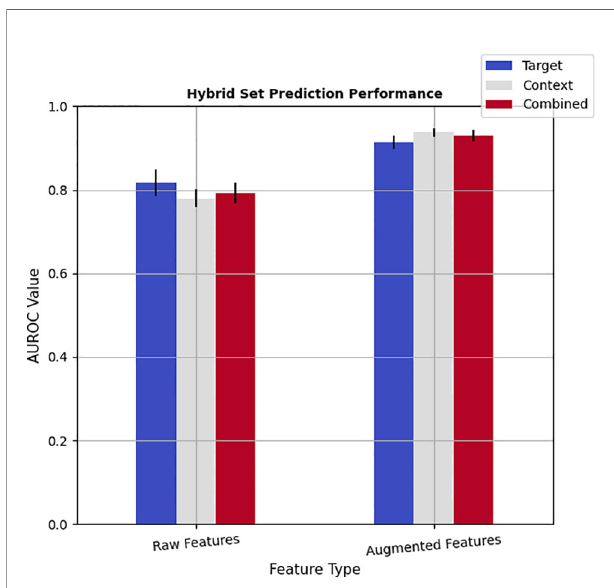
FIGURE 3 | The prediction power of the hybrid model: combinations of deep and radiomic